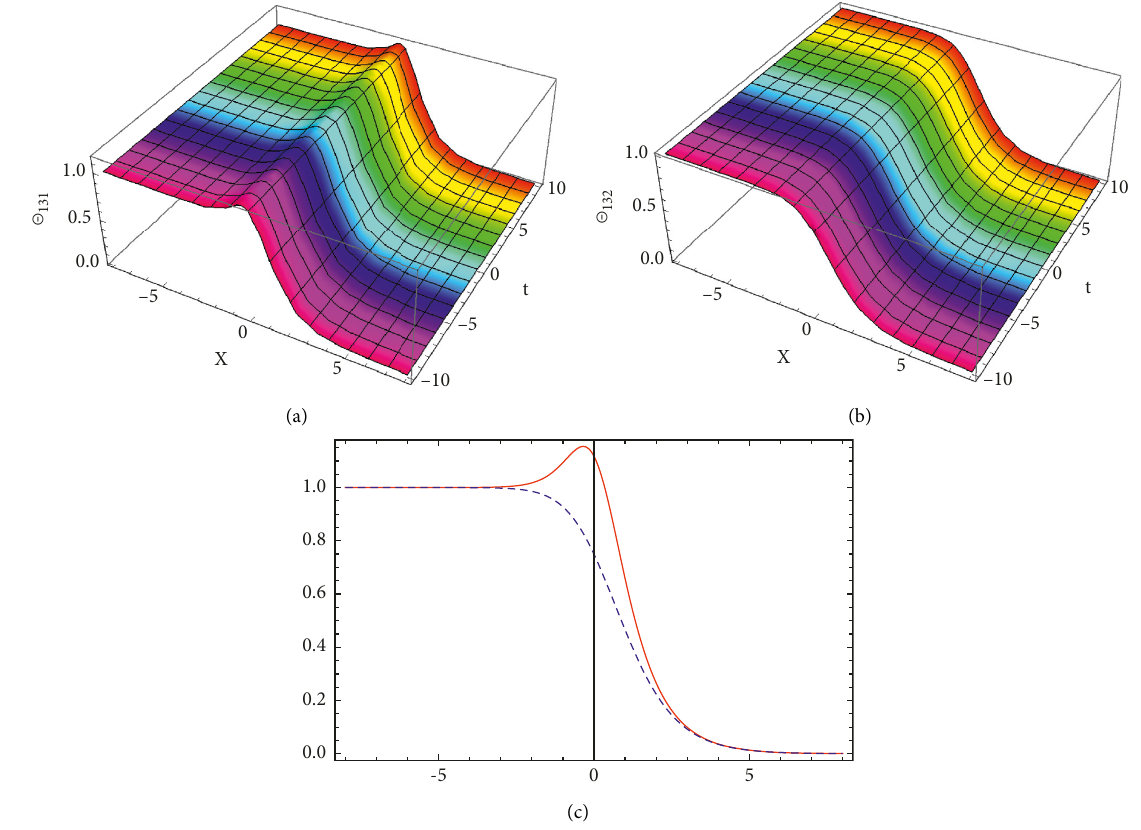
Figure 3: Plots of equation (44) and (45) for m � 2, ξ � 0 . 3, λ